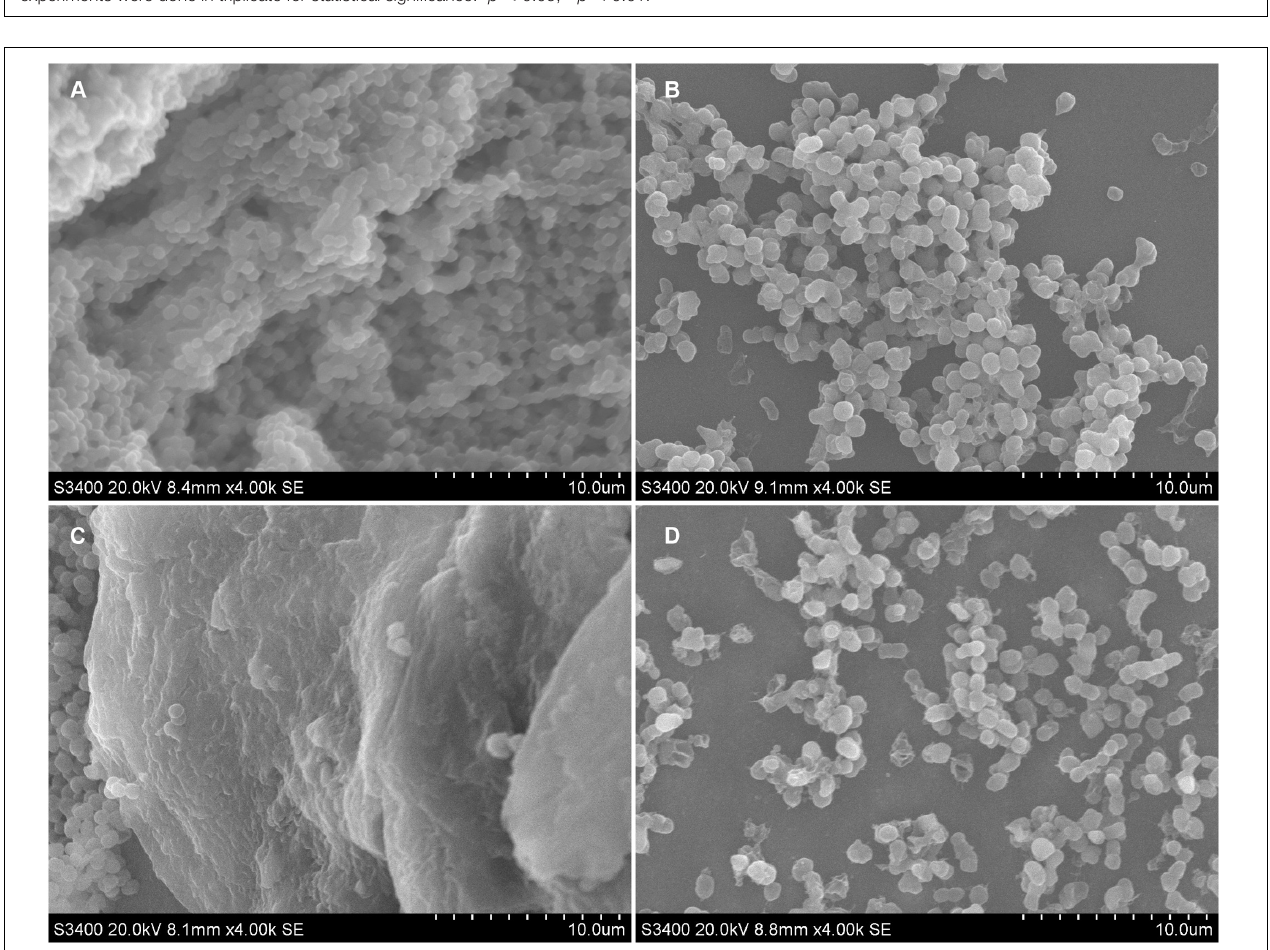
FIGURE 2 | Ultrastructural images of CRAB biofilm on sterile coverslip and catheters after treated with Cec4. (A) Coverslip without treatment, (B) Coverslip after Cec4 treatment, (C) catheter without treatment, and (D) catheter after Cec4 treatment. The selected images are the best representation of biofilms on coverslips and